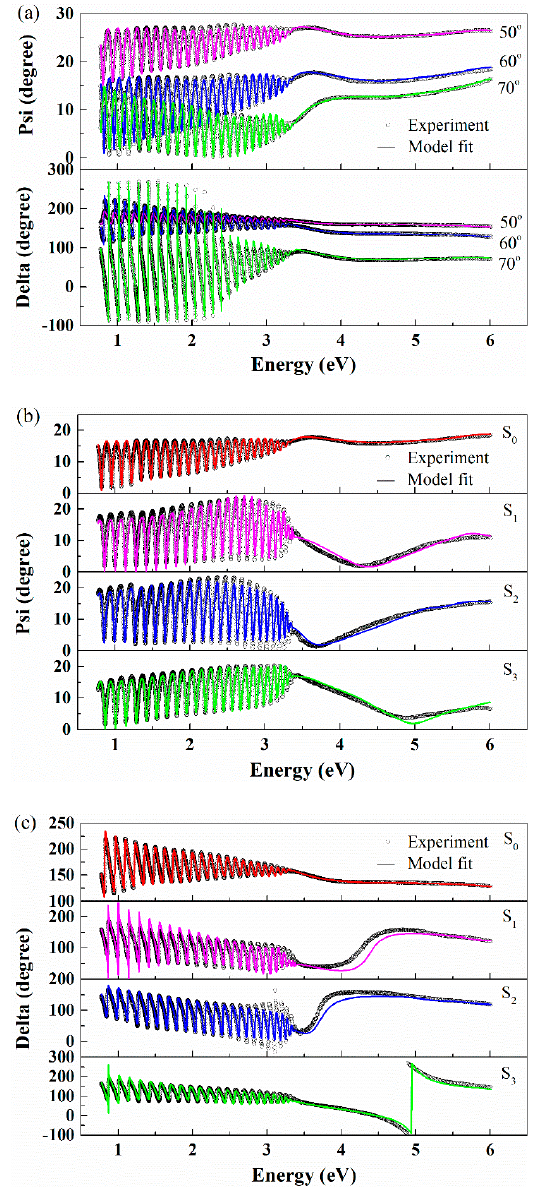
Figure 5. Spectroscopic ellipsometry (SE) experimental (dot lines) and model fitted (solid lines) ψ and Δ spectra vs energy plots: ( a ) three incident angles (50°, 60° and 70°) of Be implanted GaN sample S 0 at room temperature (RT); ( b ) and ( c ) are psi and delta with incident angle 60° for four samples at RT, respectively.